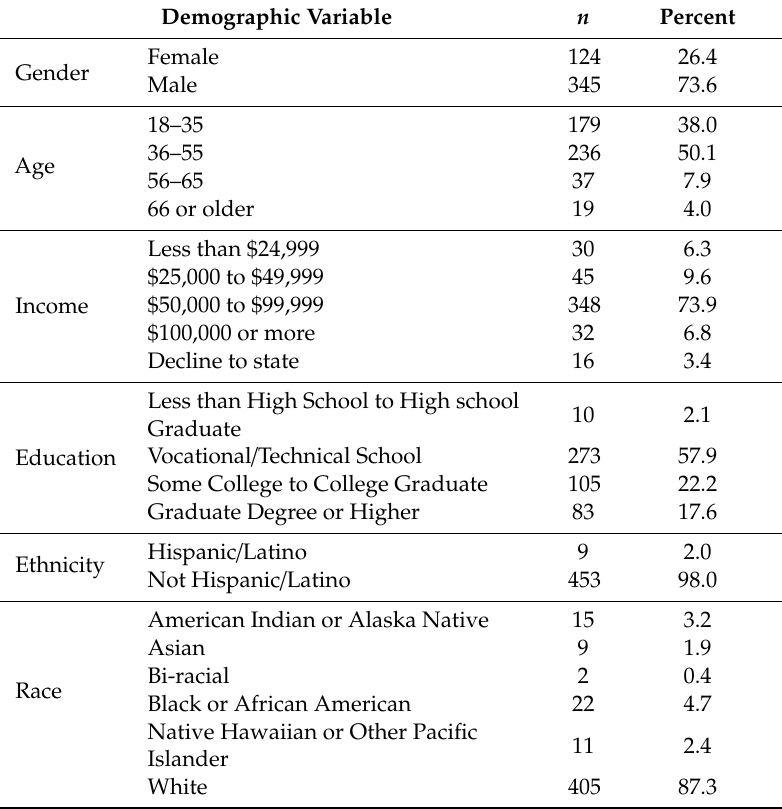
Table 2. Demographic characteristics of the questionnaire